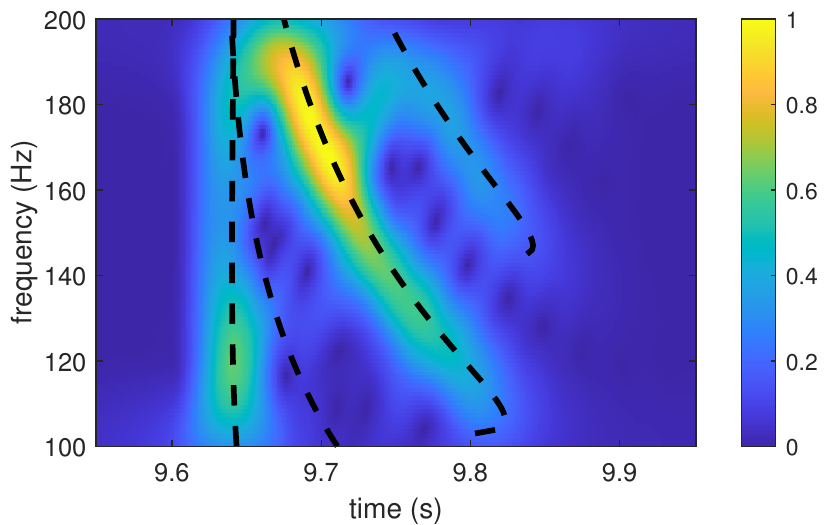
Figure 2. Normalized STFT spectrogram and dispersion curves of the simulated received signal with the nominal waveguide environment of the experiment (Figure 1).